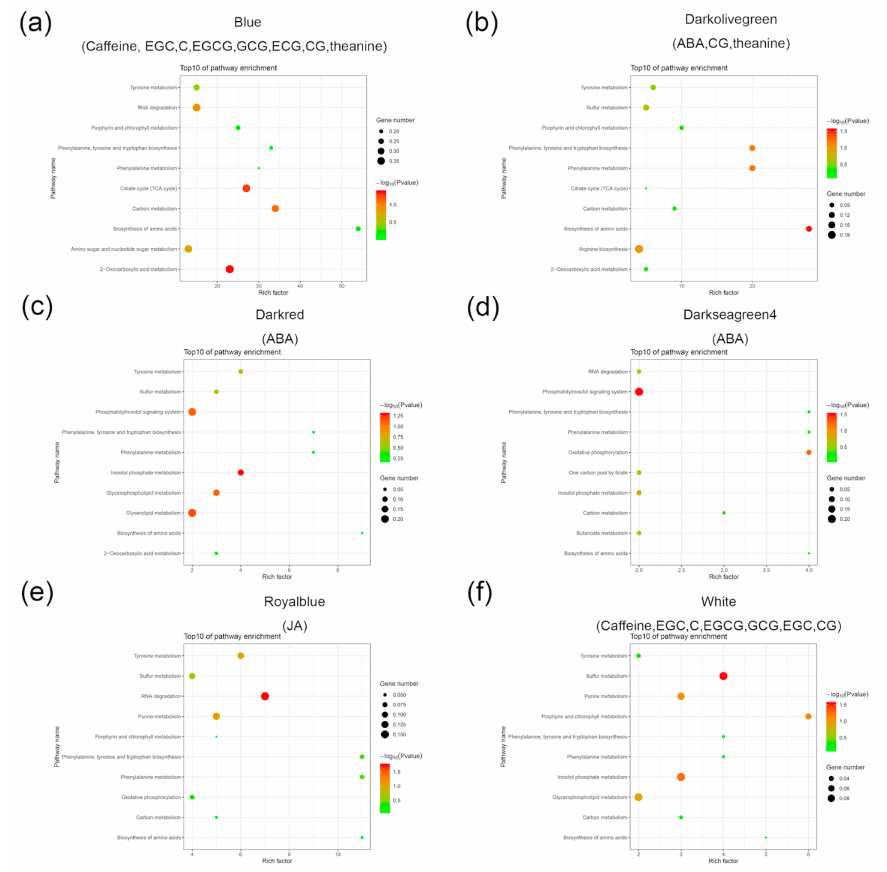
(( a ): Blue module, ( b ): Darkolivegreen module, ( c ): Daekred module, ( d ): Darkseagreen4 module, ( e ): modules ( a : Blue module, b : Darkolivegreen module, c : Daekred module, d : Darkseagreen4 Royalblue module, ( f ): White module) associated with ca ff eine and catechins. The X-axis indicates the module, e : Royalblue module, f : White module) associated with caffeine and catechins. The “rich factor”, represented by the ratio of co-expressed gene numbers to the total gene numbers of each pathway, and the left Y-axis represents the KEGG pathways. Low p values are shown in red, and high p values are shown in green on the right. The area in the circle represents the co-expressed gene